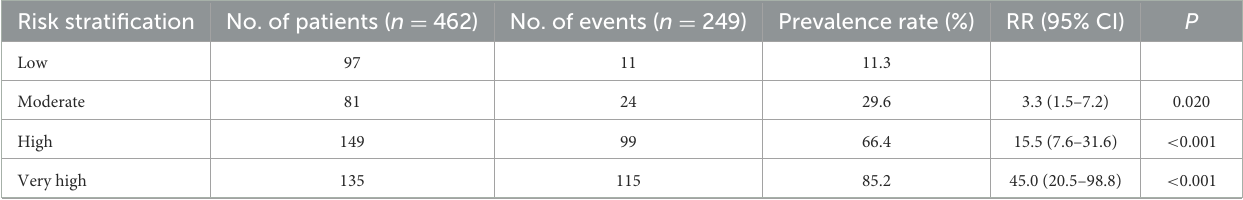
TABLE 2 Prevalence of DPN in four risk groups stratified by risk scores in the validation